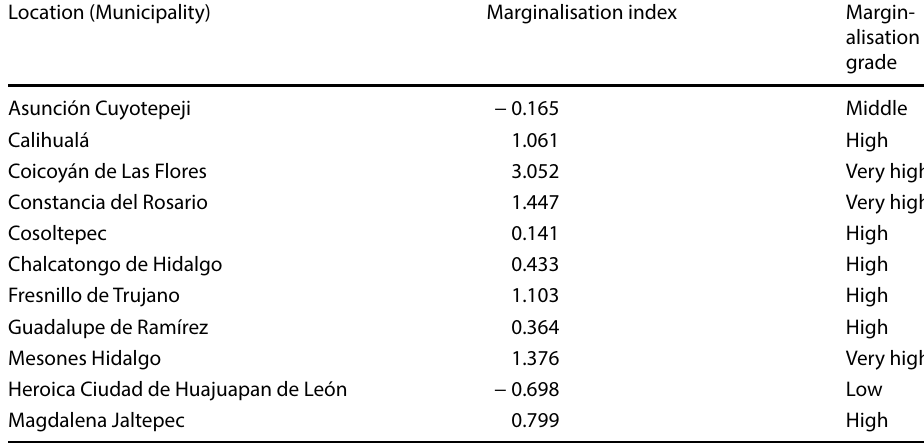
Table 6 Marginalisation index and grade for Oaxaca state sites extract